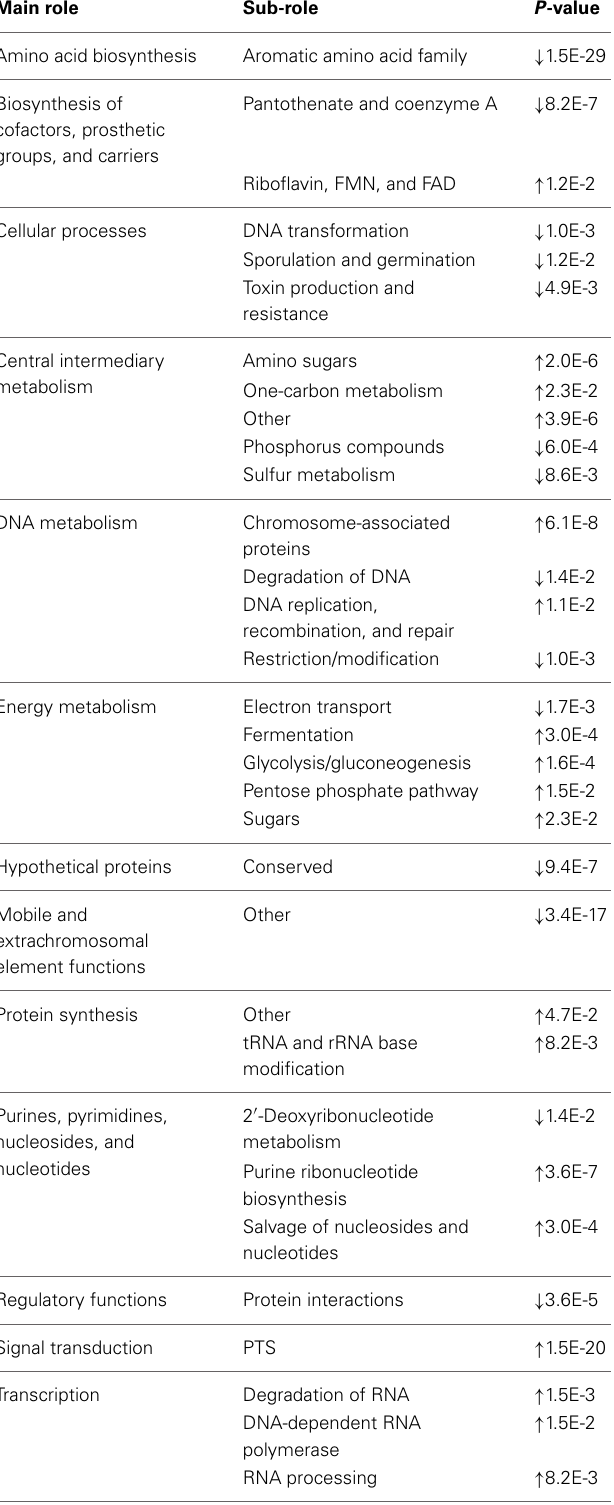
Table 4 | Comparisons of sub-roles distribution between CD − (during time points of A–E patients) and CD + (F16_D, F_after, G_before, G4_D, G_after, H35_D and H38_D)